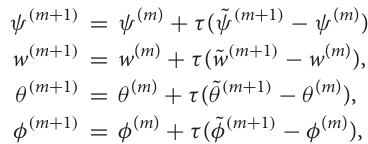
Frontiers in Physics |